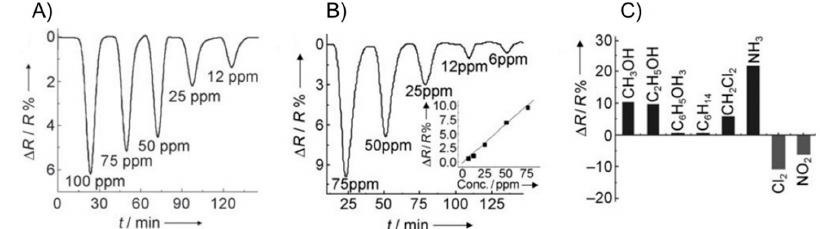
Figure 6. Example vapors sensing characterization of RGO/Inject ‐ Printed chemiresistors. ( A ) Response vs time plot of sensor response exposed to NO 2 . ( B ) Response vs time plot of sensor response exposed to Cl 2 . ( C ) Summary of sensor response for different measured media. Reproduced with permission from ref. [98]. One of the newest approaches to flexible gas sensors was proposed by H. J. Park et al. [99] They